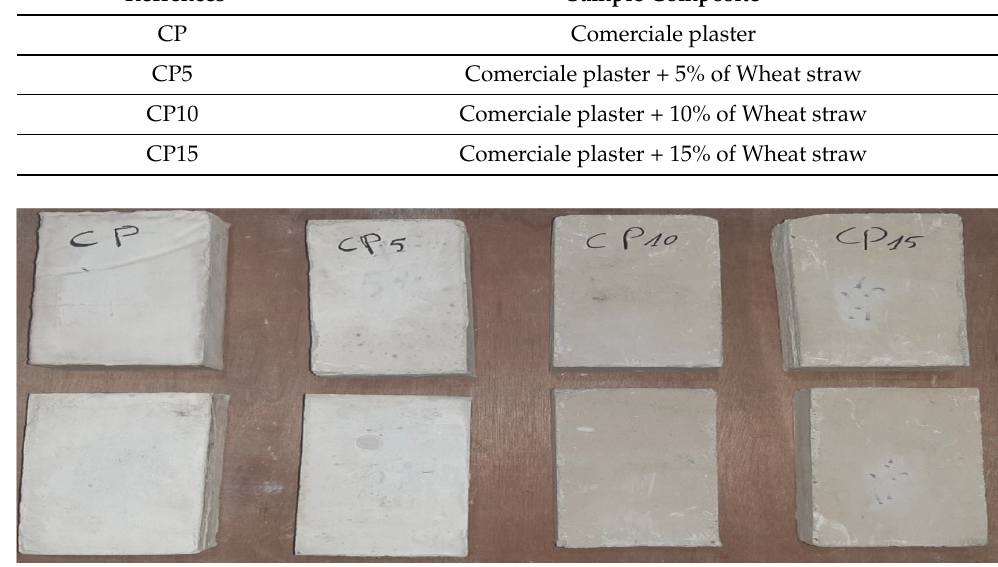
Figure 1. Picture of composite